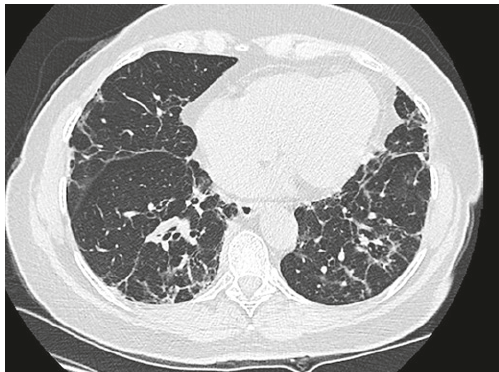
Figure 3: The chest CT scan showing the persistence of a bilat- eral interstitial syndrome associated with bronchial dilatation and pleural-based consolidations 1 year after